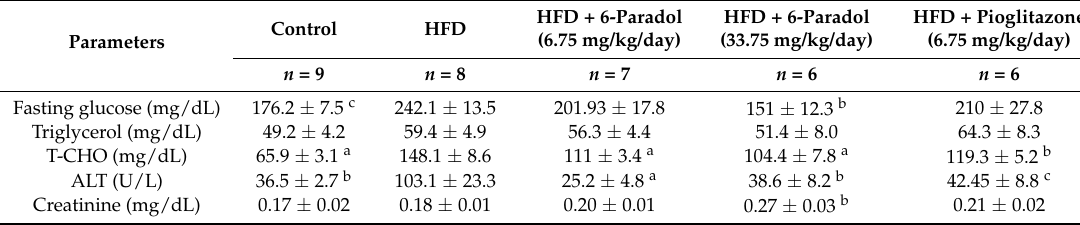
Table 1. Biochemical data of the